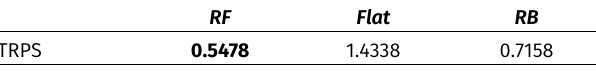
Table 7. Results of Tournament Rank Probability Score for the prediction of the world cup 2019. RF is the random forest, Flat refers to the flat prediction (equal chances for everyone) and RB is the rank-based reference prediction (higher ranked player